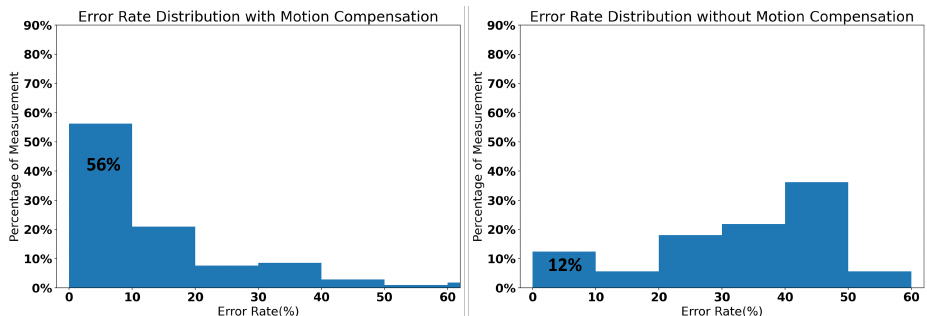
Figure 17. HR measurement error rate when participants drive on a local road with motion compen- sation ( left ) and without motion compensation ( right ).